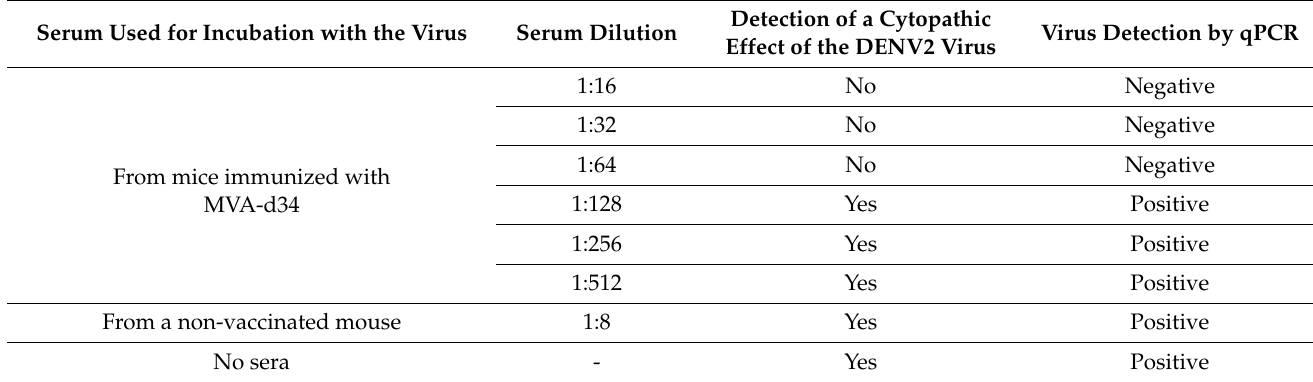
Table 3. The results of the study of the virus-neutralizing activity of blood sera from mice immunized with MVA-d34 and non-vaccinated